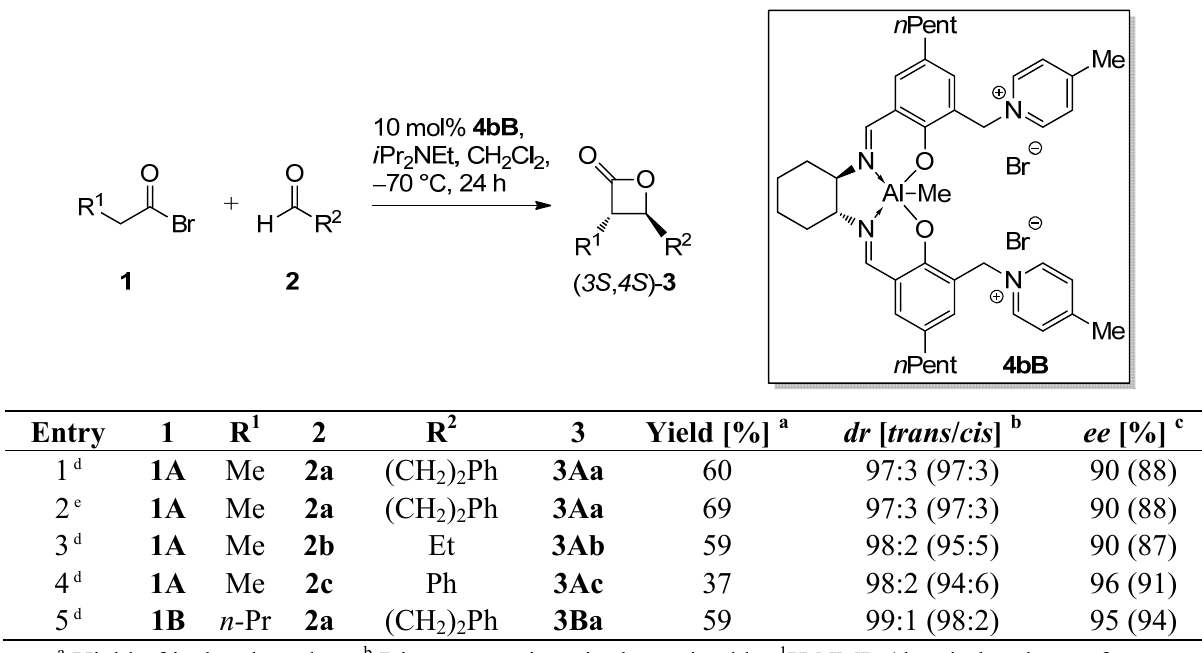
Table 3. Asymmetric synthesis of trans -configured β -lactones 3 catalyzed by the aluminum bis-picolinium catalyst 4bB